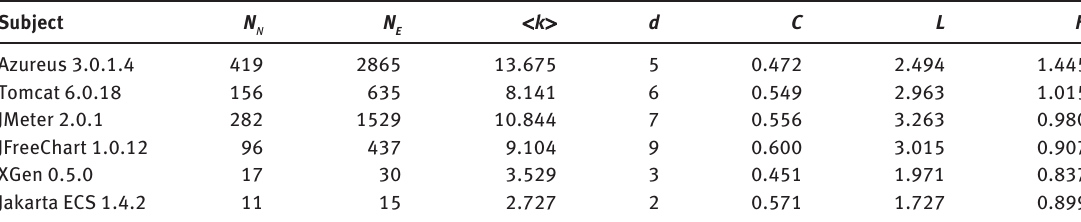
Table 2. Statistical Properties of the PDNs Built from the Six Subject Software